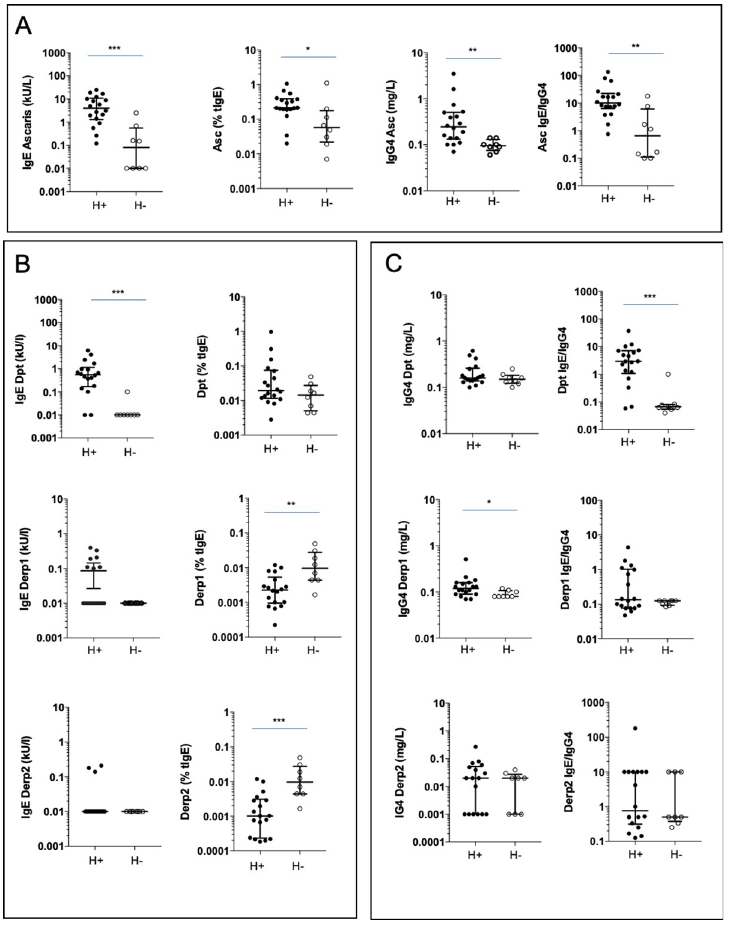
Fig 1. House dust mite and Ascaris IgE and IgG4 responses. IgE and IgG4 against Ascaris (A), IgE (B), and IgG4 (C) against D . pteronyssinus (Dpt), Derp1, and Derp2 in subjects with (H+) and without (H-) helminth infection. � p < 0.05, �� p < 0.01, ��� p < 0.001, Mann-Whitney